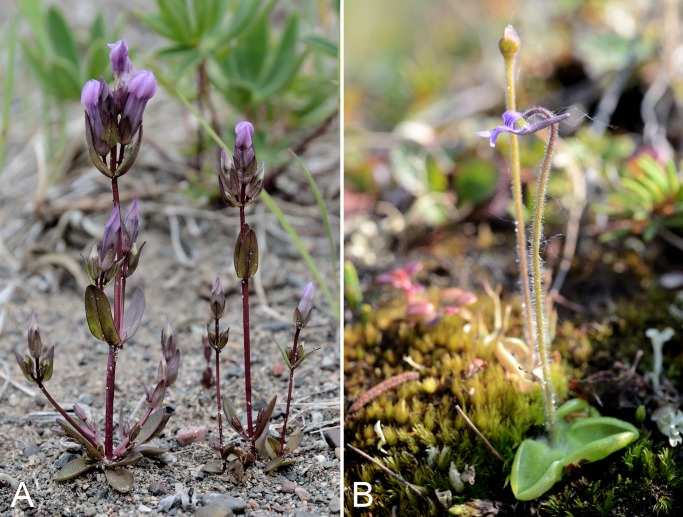
Gentianella propinqua subsp. propinqua and Pinguicula villosa.Gentianella propinqua subsp. propinqua: (A) habit, Saarela et al. 4188. Pinguicula villosa: (B) habit, Saarela et al. 4278. Photographs by R. D. Bull.